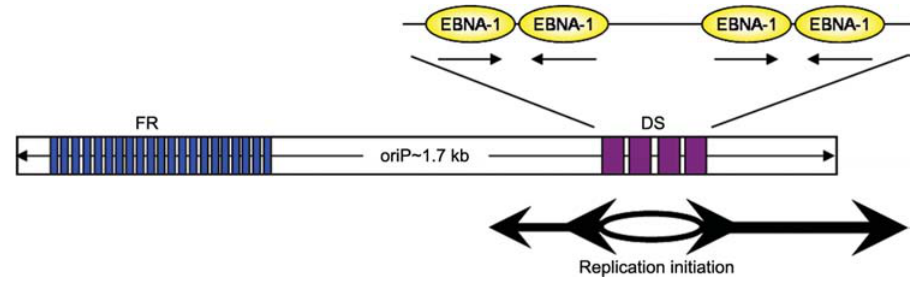
Figure 4 Replication of the EBV genome is mediated by oriP and EBNA-1. The oriP of EBV consists of the dyad element (DS, purple) and the family of repeats element (FR, blue). The FR harbors 20 copies of the EBNA binding site and functions as a replication enhancer. The DS element harbors four palindromic EBNA-1 binding sites and represents the replication initiation and start site of EBV (black arrows).